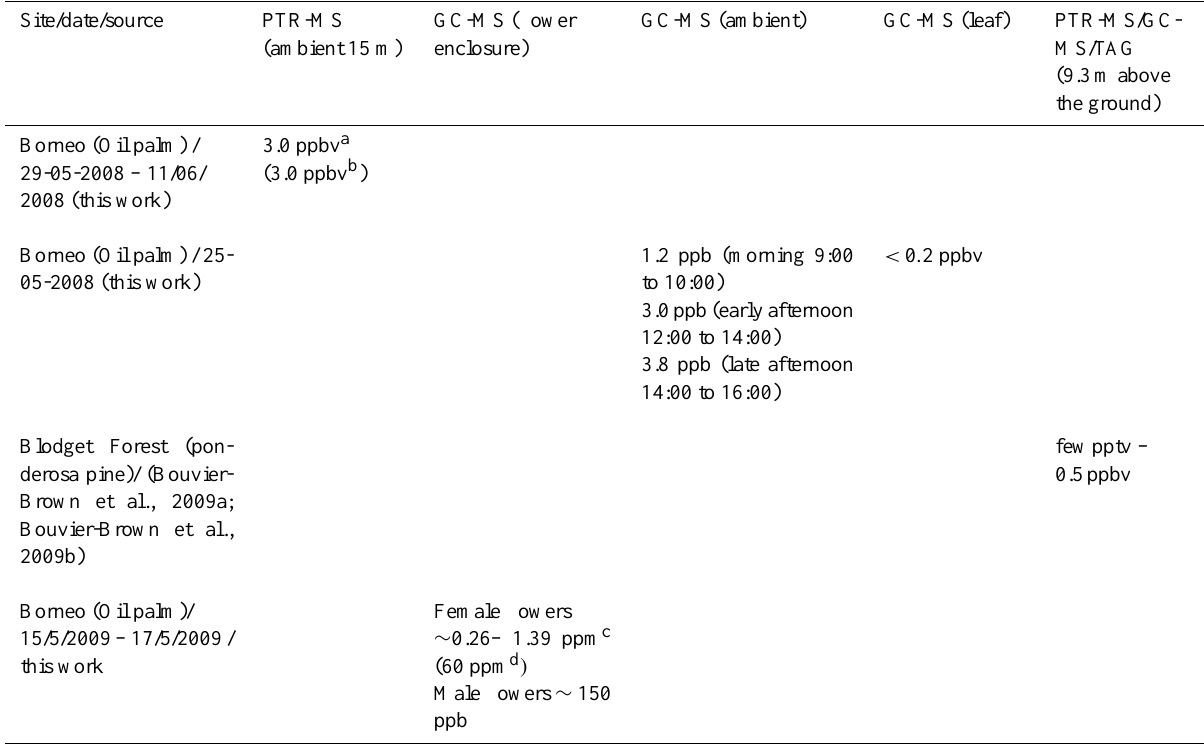
after applying the time lag of 3.5